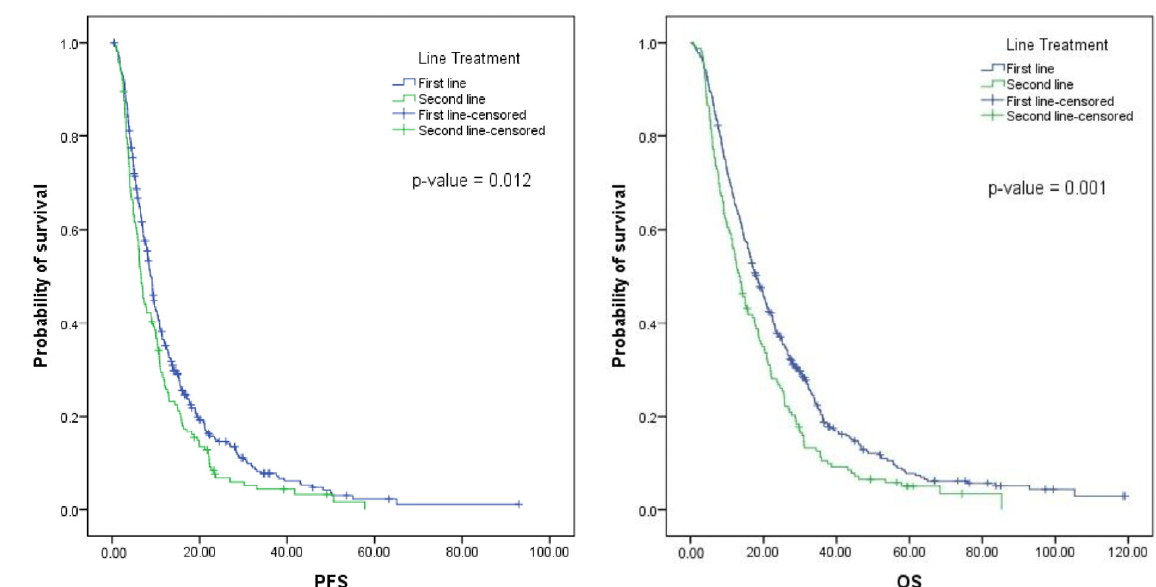
Figure 1. Survival curves of patients with mCCR treated with bevacizumab. Table 3. Disease control rate and rate of response for patients with mCRC treated with bevacizumab and chemotherapy in the first and second